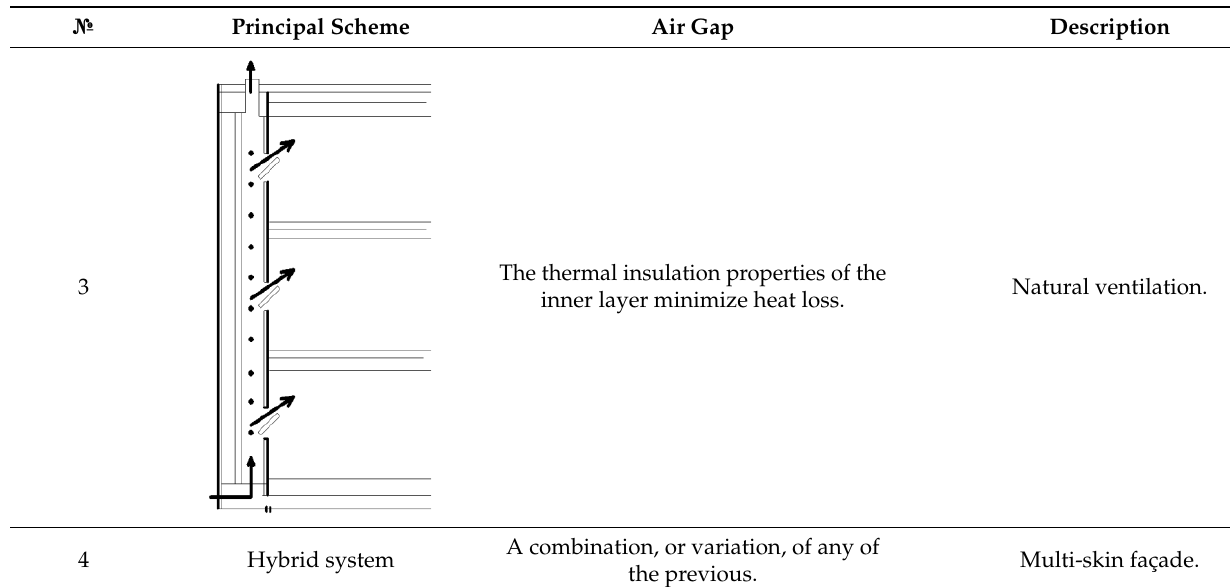
Figure 17. Adaptive ventilated facades with controlled thermal characteristics. ( a ) summer daytime, ( b ) summer night, ( c ) winter.